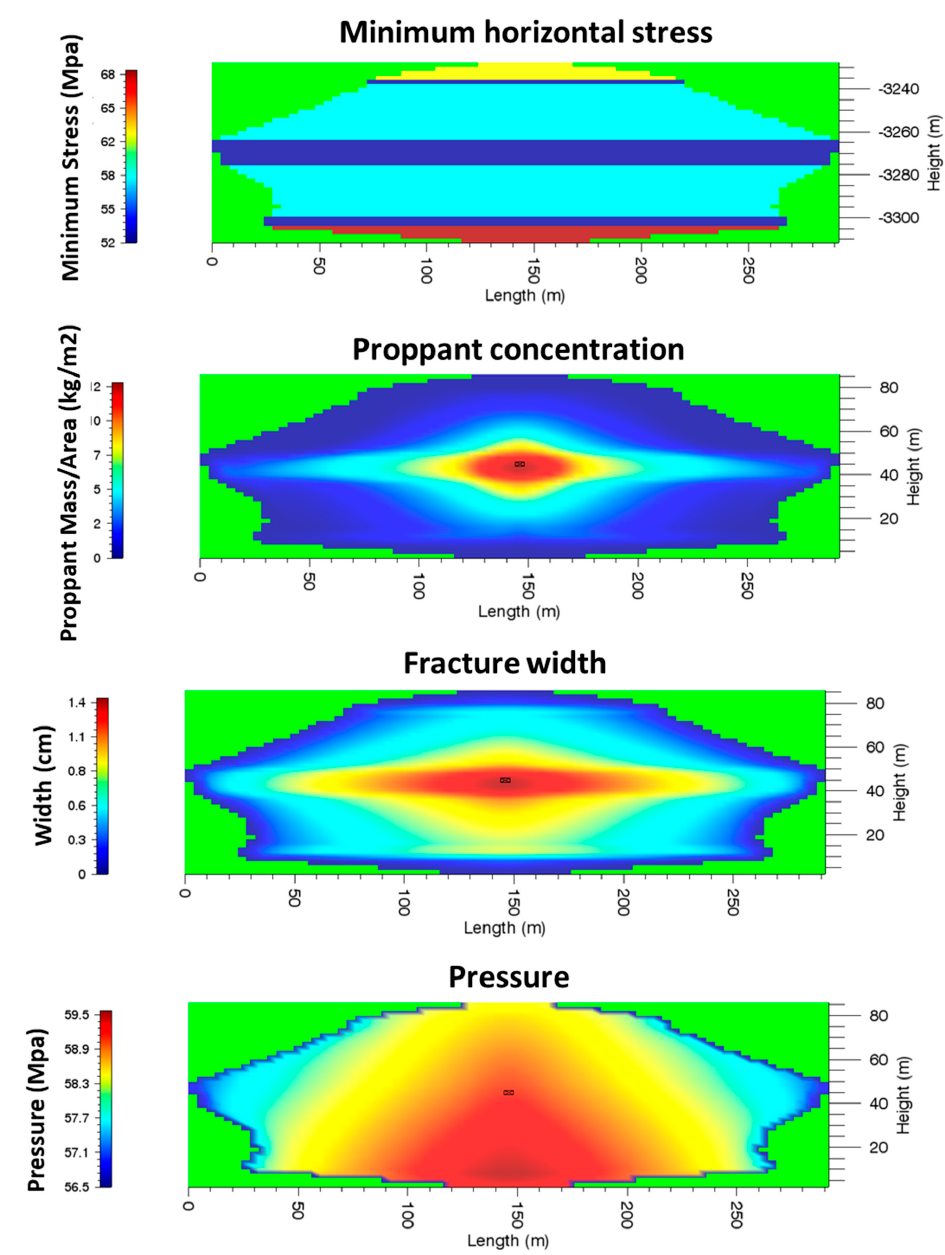
Figure 14. The stress profile, fracture width, proppant concentration and fluid pressure across the fracture of Case 3.